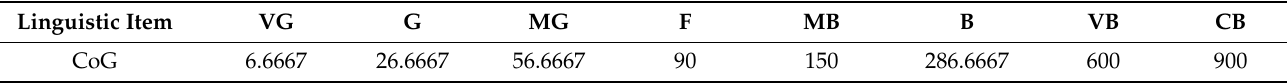
Table 7. CoG values of output